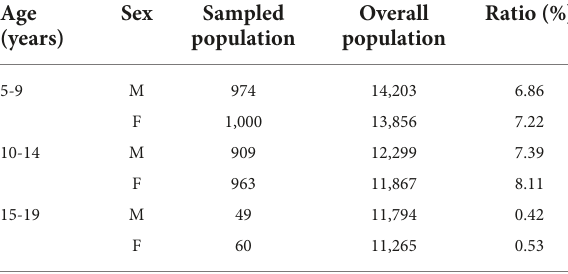
TABLE 1 Ratio of 2019’s sampled population to 2020’s overall population in